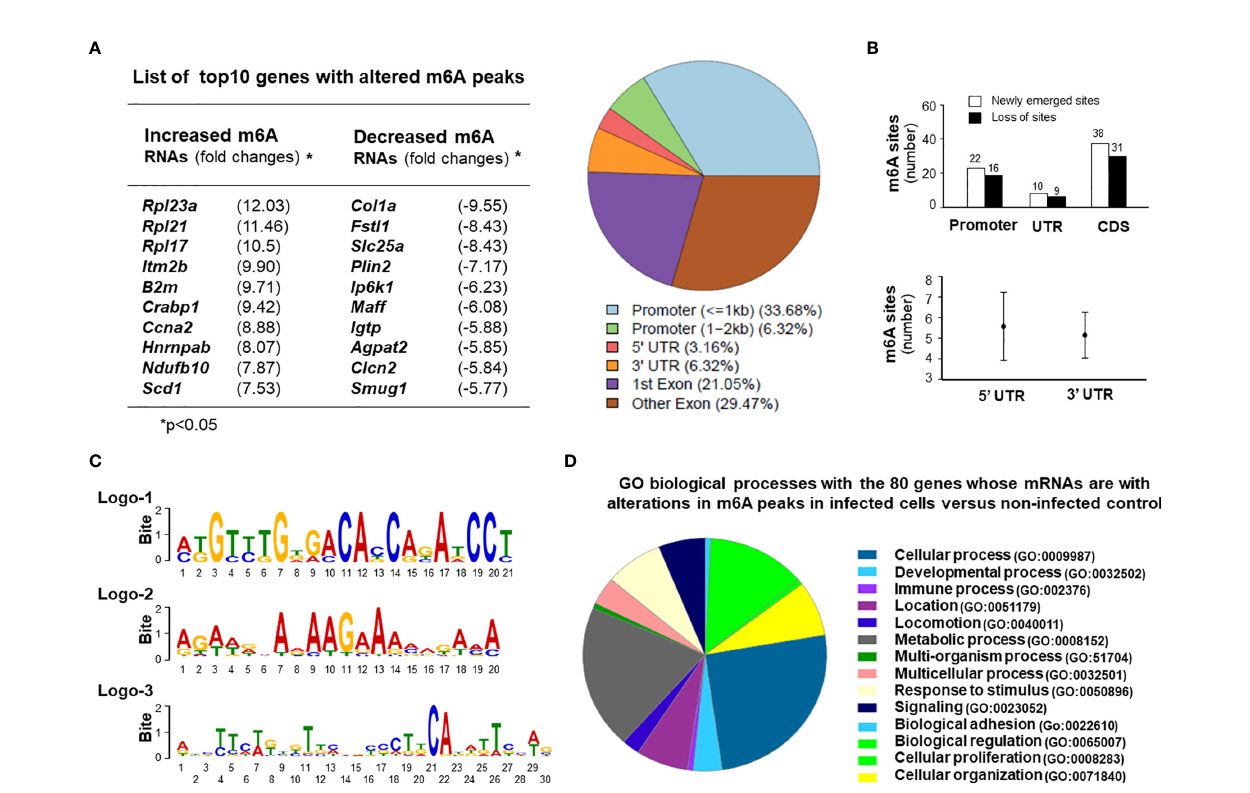
FIGURE 5 | Alterations in the topology of host m 6 A mRNA methylome in intestinal epithelial cells following C. parvum infection. (A) C . parvum infection caused signi fi cant alterations in m 6 A levels in the 118 regions of 80 corresponding genes in the transcriptome in IEC4.1 cells. Cells were exposed to C. parvum infection for 24h. Total mRNAs were collected and processed for m 6 A-RIP-Seq analysis. Top 10 genes with altered m 6 A modi fi cations (either with an increased m 6 A peaks or a decreased m 6 A peaks) in infected cells are listed. These regions at the promoters, untranslated regions (UTRs) and coding sequence (CDS) regions with signi fi cant increase or decrease of m 6 A peaks from the infected cells are shown. (B) Sites of altered m 6 A methylation in the promoters, UTRs, and CDS regions in cells following C. parvum infection. (C) The motifs with altered m 6 A modi fi cations in IEC4.1 cells following infection. Three logos were identi fi ed and listed. (D) Gene ontology (GO) analysis of the genes with changed m 6 A peaks in cells following C. parvum